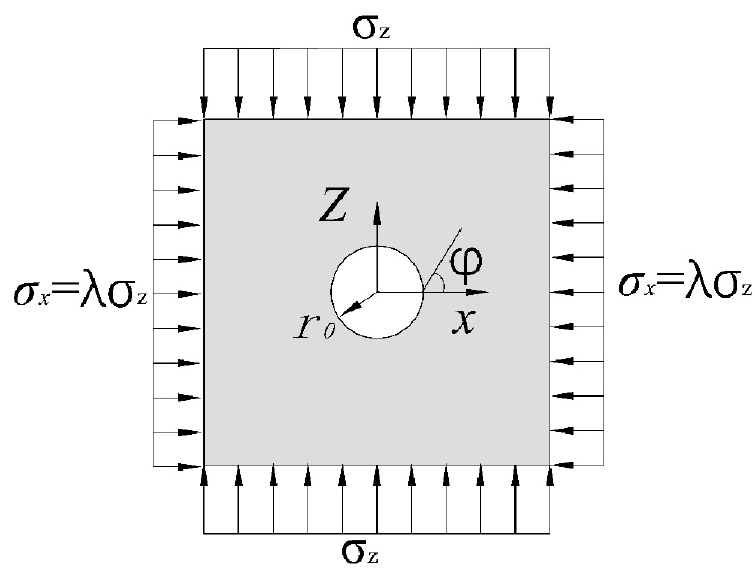
Figure 2. Stress state of roadway surrounding rock without circular support.